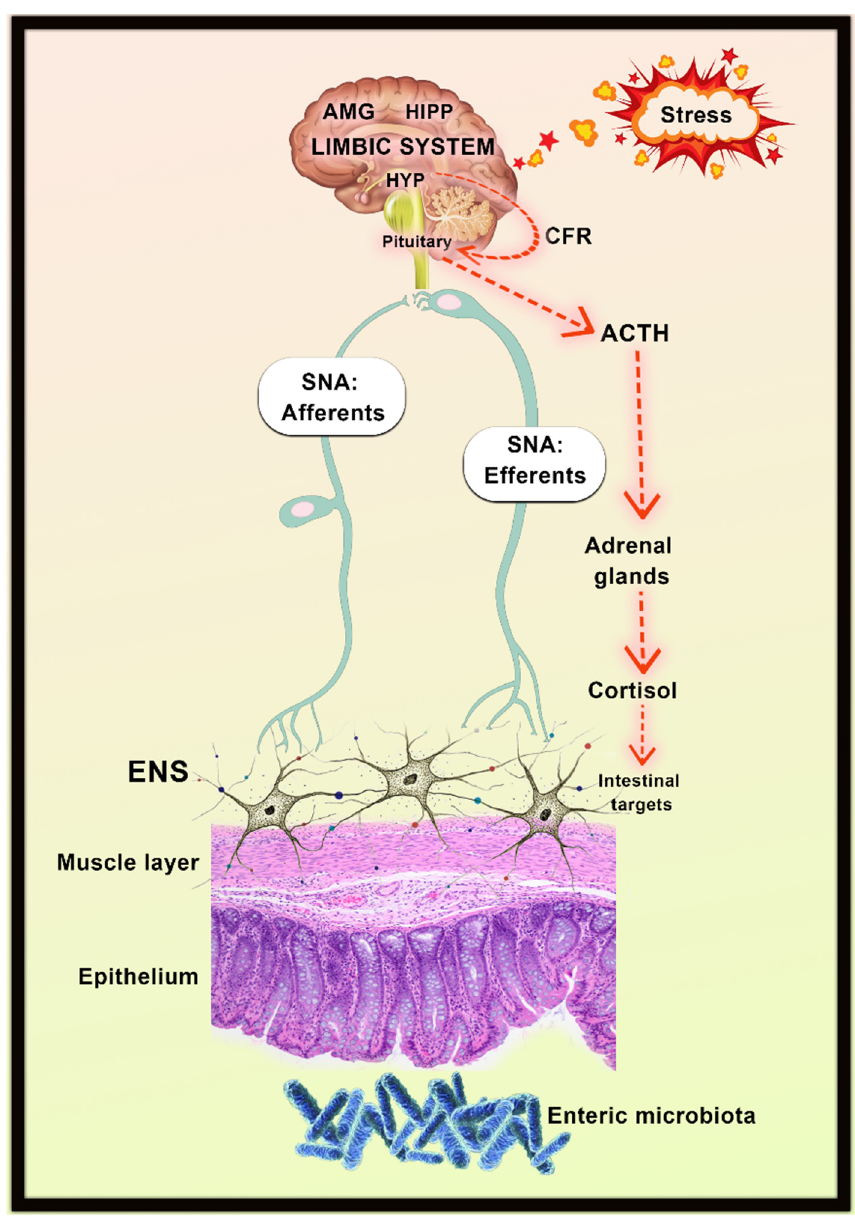
Figure 3. The structure of the microbiome–gut–brain axis. The HPA axis (in dashed line) in the CNS can be activated in response to environmental factors, including stress or emotion. Through a complex interaction between the AMG, HIPP, and HYP, constituting the limbic system, HPA is finalized to cortisol release. The secretion of the CRF from HYP stimulates the secretion of ACTH from the pituitary gland, leading to the release of cortisol from the adrenal glands. CNS communicates with afferent and efferent pathways with intestinal targets such as muscle layers and gut mucosa, ENS, modulating motility, permeability, immunity, and mucus secretion. The enteric microbiota has bidirectional communication with these intestinal targets that modulate the gastrointestinal functions and modulates itself by gut–brain interactions. HPA, hypothalamic pituitary adrenal; CNS, central nervous system; AMG, amygdala; HIPP, hippocampus; HYP, hypothalamus; CRF, corticotropin-releasing factor; ACTH, adrenocorticotropic hormone; ENS, enteric nervous